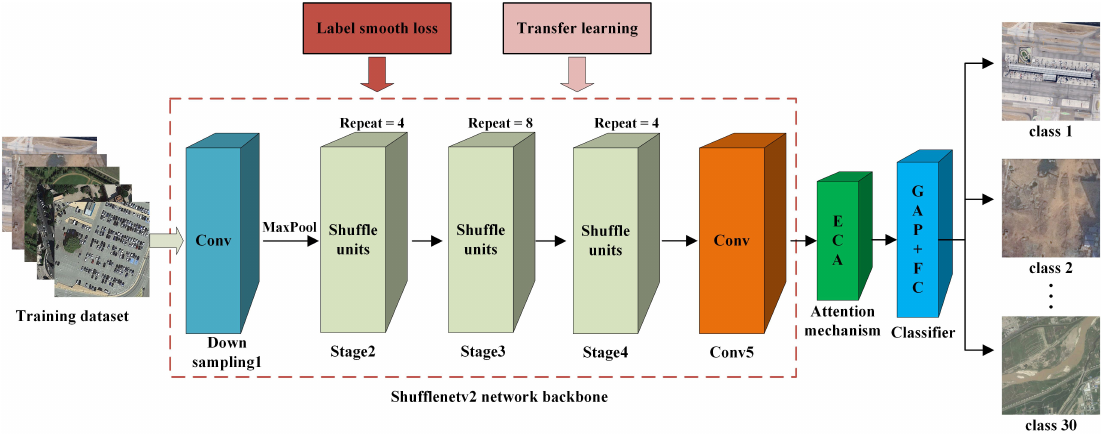
Figure 3. The overall framework of the RSSC